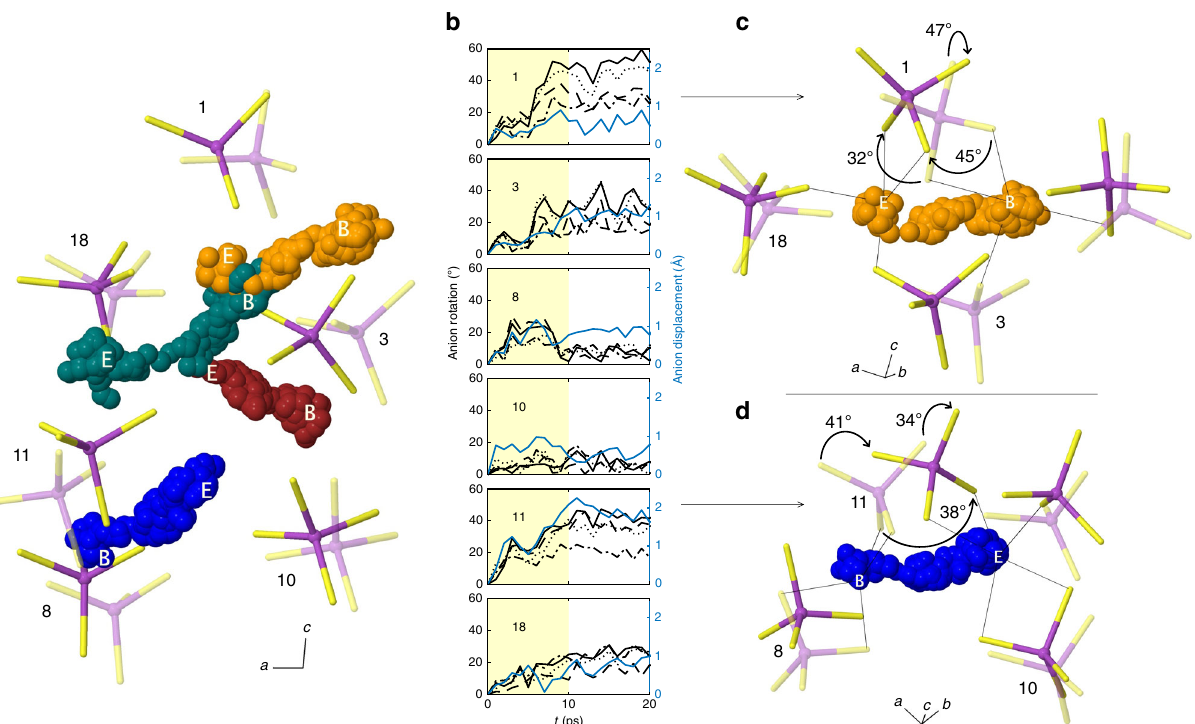
Fig. 4 Illustration of cation – anion cooperative motion at 300 K. a Distinct colored spheres represent the positions of four different lithium ions superimposed at 40-fs intervals over a 10-ps trajectory; the initial and fi nal positions of these ions are labeled “ B ” and “ E ” , respectively. Tetrahedral PS 4 anions are colored magenta (phosphorus) and yellow (sulfur). The initial positions of the anions at the start of the migration event are shown with partial transparency; opaque depictions indicate fi nal positions. Numeric labels identify individual anions. For clarity, only a portion of the simulation cell is shown. b Angular (black) and linear (blue) displacements of the PS 4 anions as a function of simulation time. (Angular displacements are plotted for each of the four vectors parallel to a P – S bond in a PS 4 anion.) Yellow shading represents the time window over which a cooperative displacement occurs. c , d Diffusion mechanisms for the orange and blue Li ions from panel ( a ), illustrating the coupling of cation transport with the reorientation of anions. Black lines illustrate the evolution of the coordination environment of lithium as it moves from the beginning (B) and end points (E) of the migration displacement. Arrows identify the two anions (numbers 1 and 11) that exhibit the largest rotational displacements. The magnitudes of the largest anion reorientations are identi fi